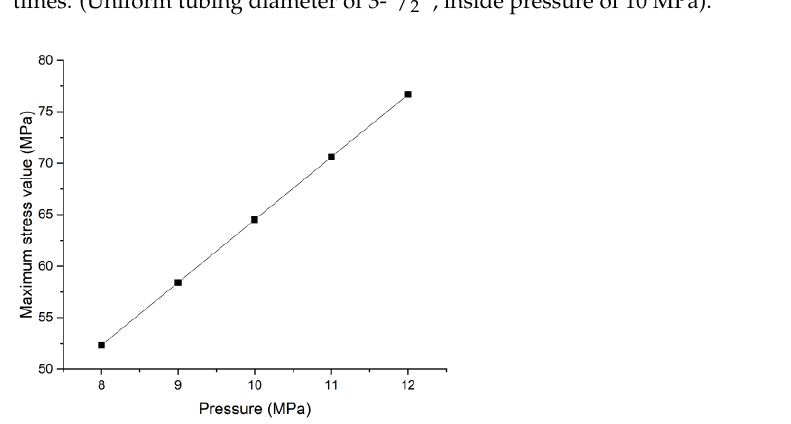
Figure 14. Maximum value of axial additional stress for different pump shutdown pressures. (Uni- form tubing diameter of 3- 1 / 2 ″, pump shutdown time of 6 s).